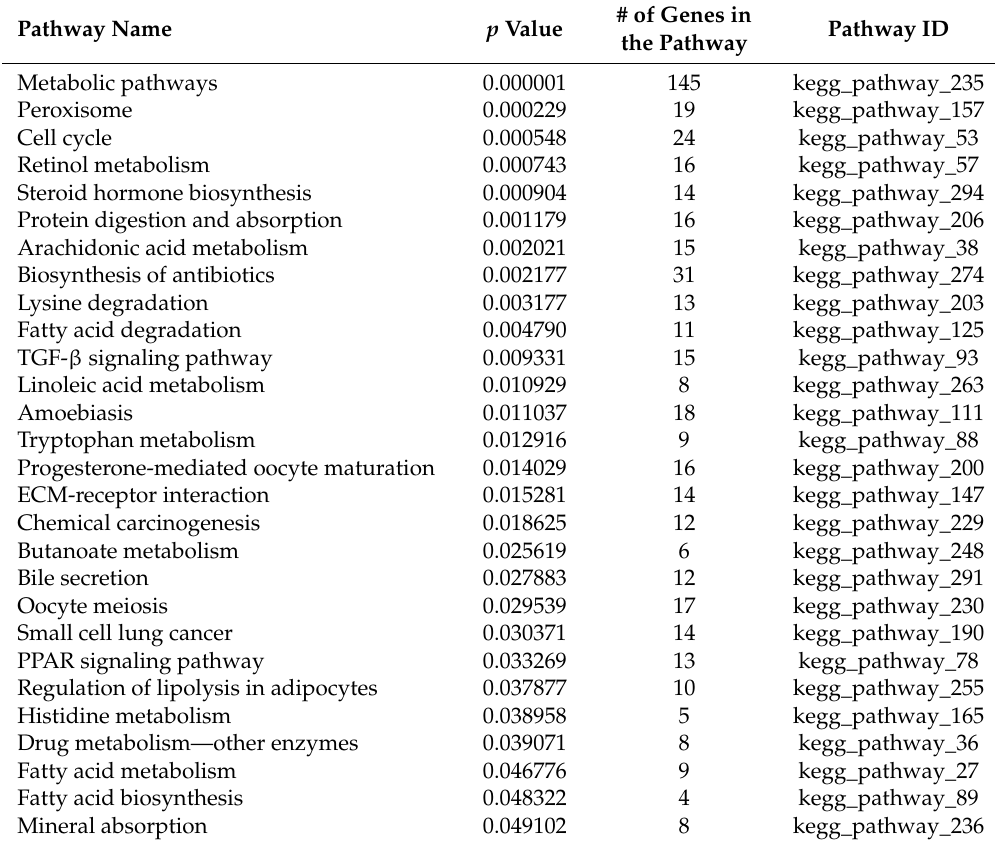
Table 1. Results of pathway enrichment analysis on the 2173 genes differentially expressed in the WT-BDL vs. WT-Sham comparison alone.